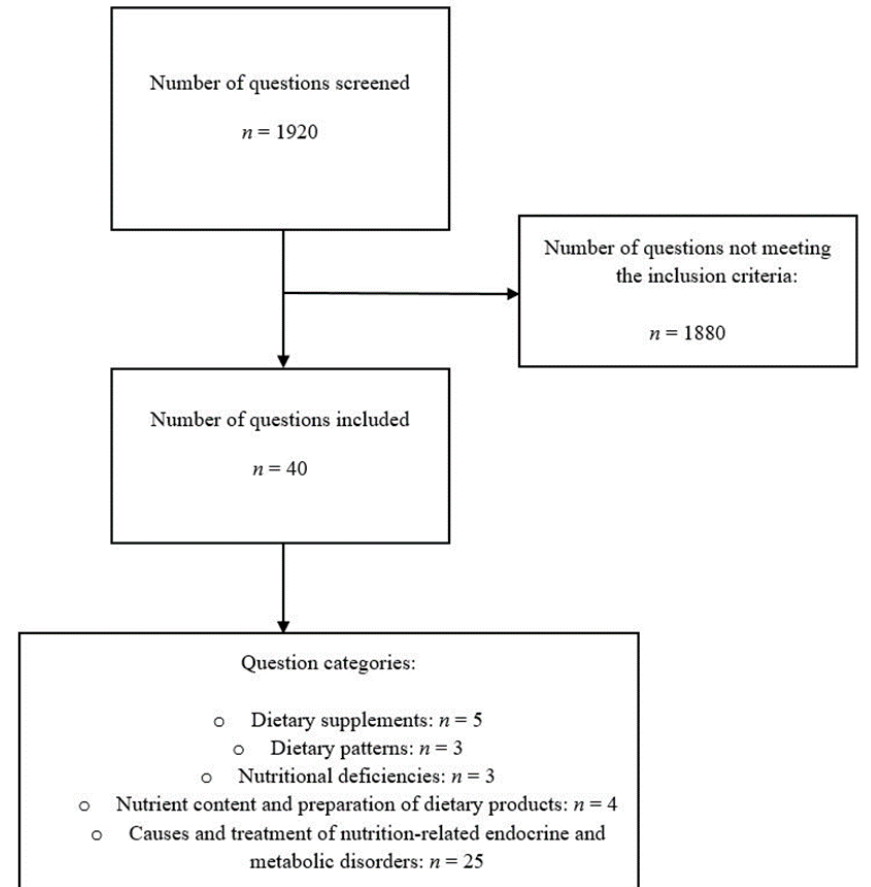
Figure 1. Flowchart for inclusion of multiple-choice questions and question classification.